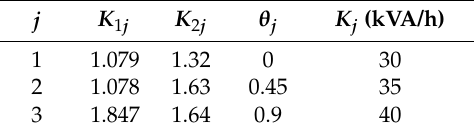
Table 2. Cost coefficients to customers classification and interruptibility limits.